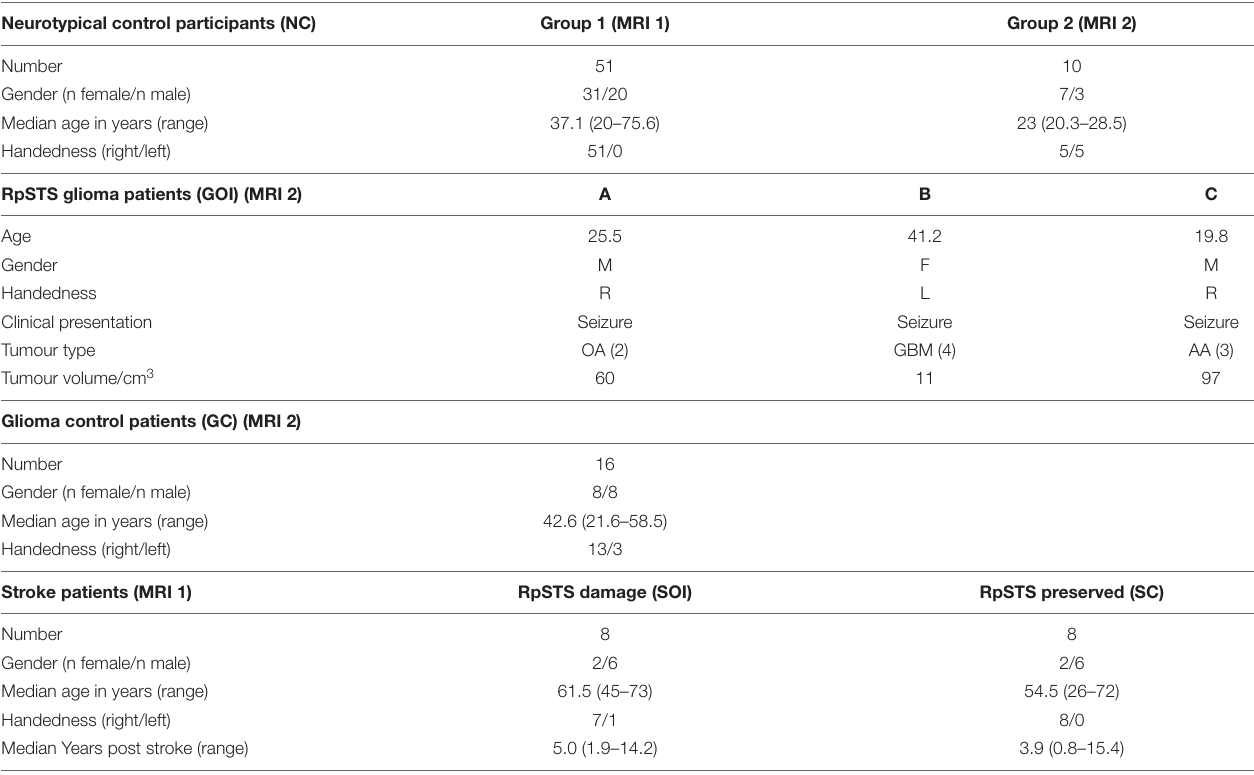
TABLE 1 | Participant